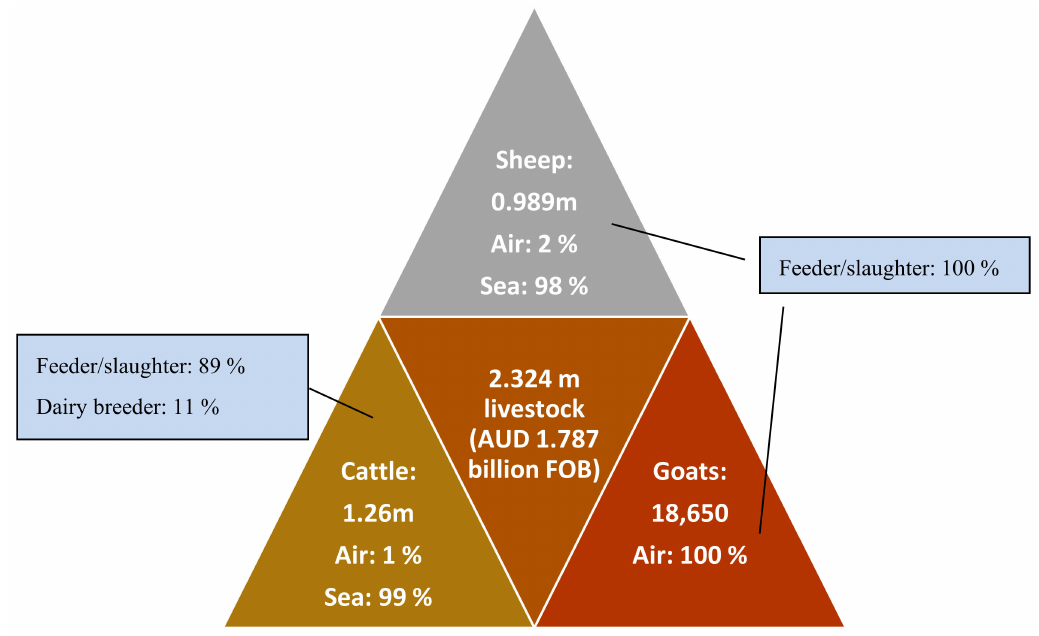
Figure 1. Animal numbers for live export from Australia for 2018 / 9 [15] by species (sheep, cattle, goats) and transport (air or sea), and total Free on Board (FOB)—value at the time of selling / buying the animals in Australia (i.e., the values quoted here do not include the cost of shipping / transport). Most cattle and sheep are transported by sea, principally to south-east Asia and the Middle East (cattle and sheep respectively), while goats are largely transported by air to south-east Asia. Because most animals are transported by sea, most animal welfare measures have addressed this form of transport; much less has been done about animal welfare as part of air freight